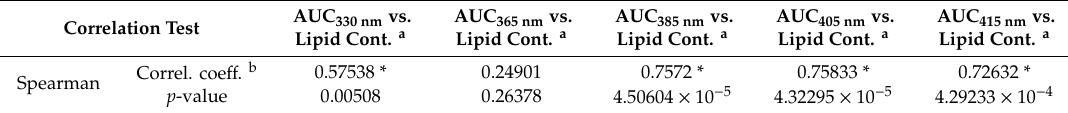
Table 1. Correlation between fluorescence measurements and lipid quantification from morphometry. Correlation